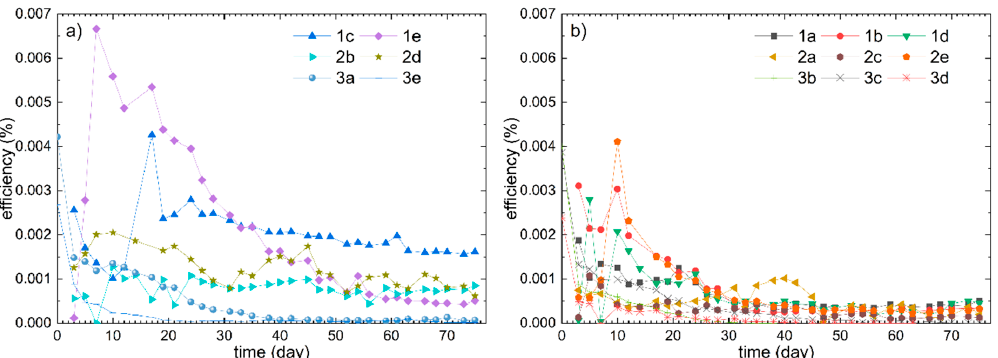
Figure 2. Comparison of the efficiency progressions of samples 1, 2 and 3. The two more efficient DSSCs per sample are depicted in ( a ) and the remaining DSSCs in ( b ). In the electrolyte of sample 1, 17 wt% PEO was applied and 8 wt% PEO in sample 2. Sample 3 contained 6.4 wt% PEO and 1.6 wt% PVDF.